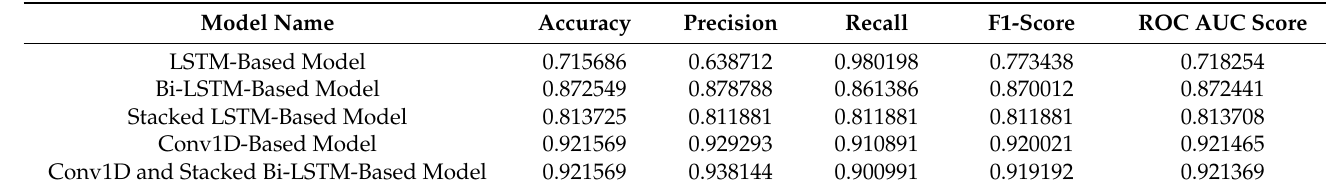
Figure 5. Performance comparison among the different models in terms of accuracy for training, validation, and test dataset. Table 4. The performance of gender detection from Bangla name data.